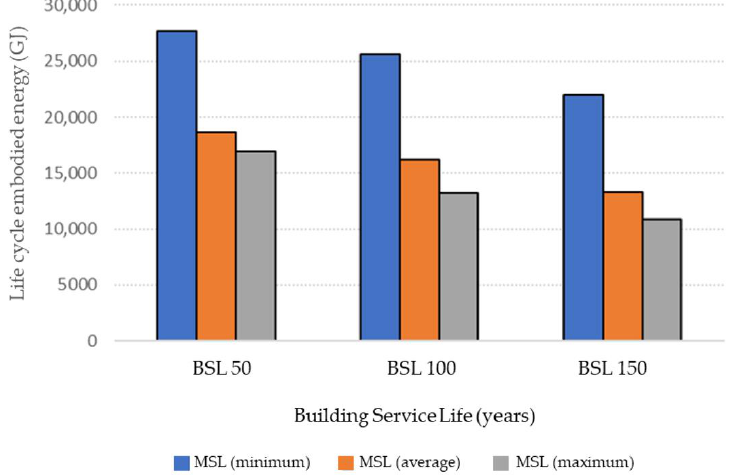
Figure 9. Life cycle embodied energy of the case study house with the minimum, average and maximum material service lives for 50, 100 and 150 years over an assessment period of 150 years.